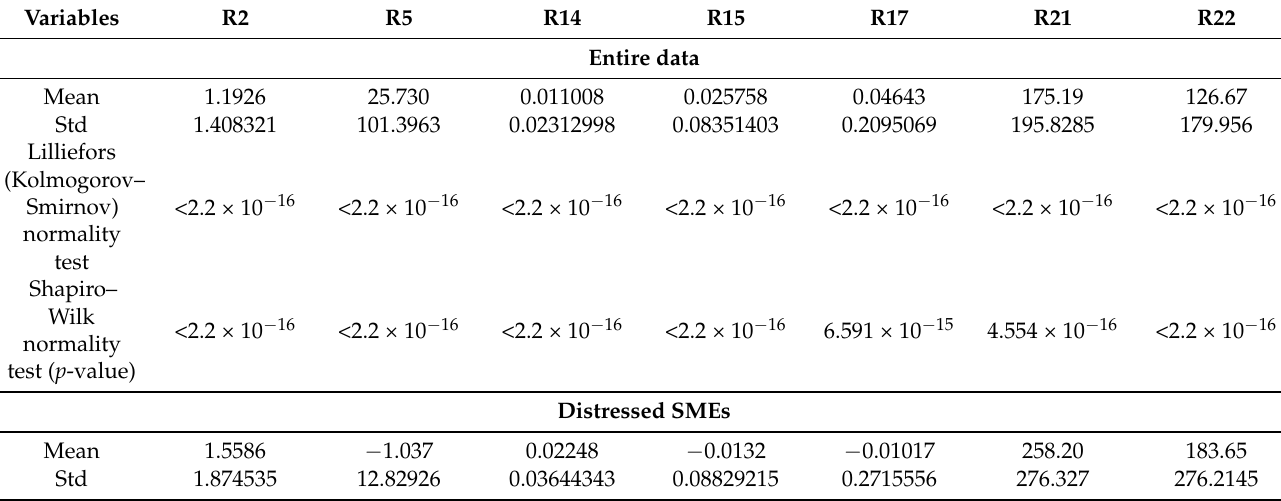
Table A2. Descriptive statistics for variables selected by lasso technique, year